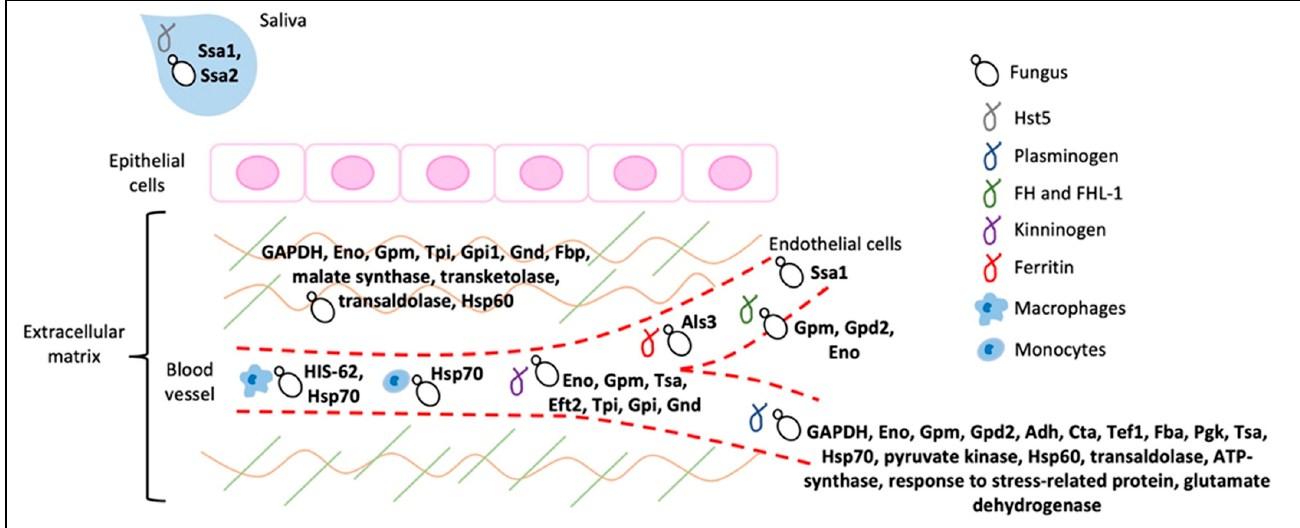
Figure 3. C. albicans cytoplasmic adhesins. Adhesins are bolded, and their binding partners are cartooned. Reprinted with permission from [34]: 2022, Hector Mora-Montes.